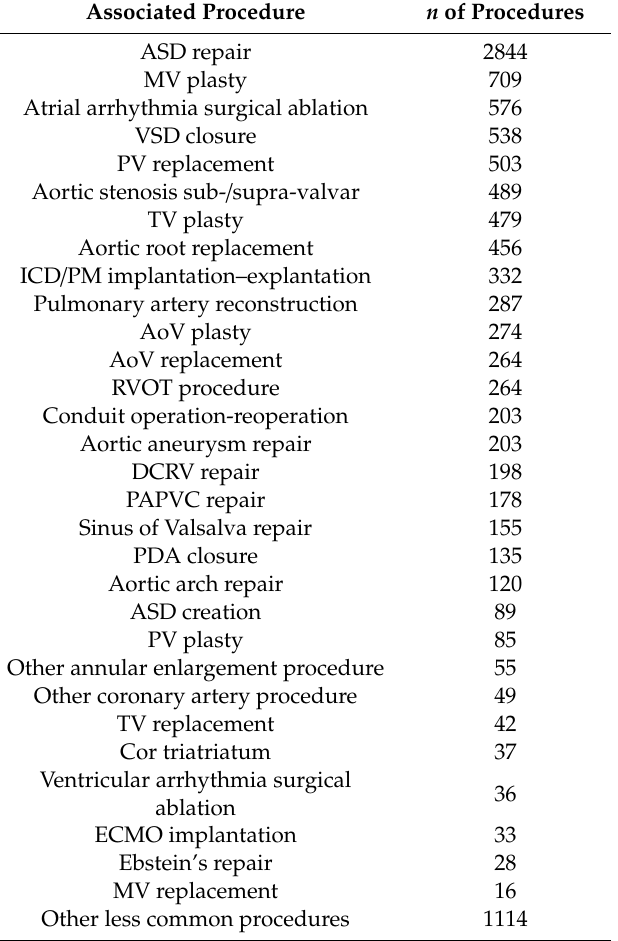
Table 3. Associated procedures ( n = 10,678 in 7564